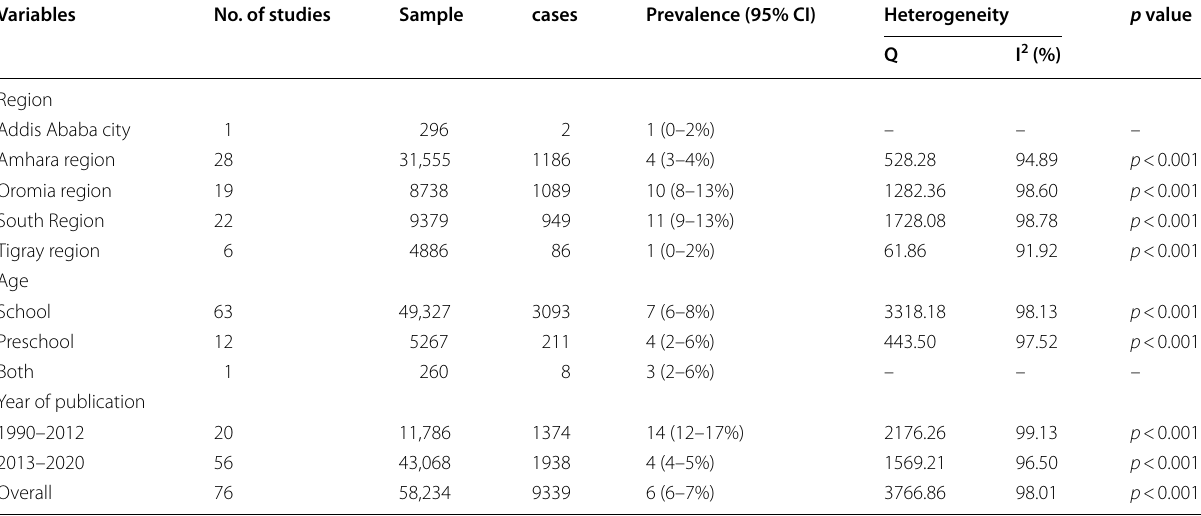
CI Confidence interval Table 6 Pooled prevalence of species specific Hookworms by region, age and year of publication among Ethiopian children, 2020